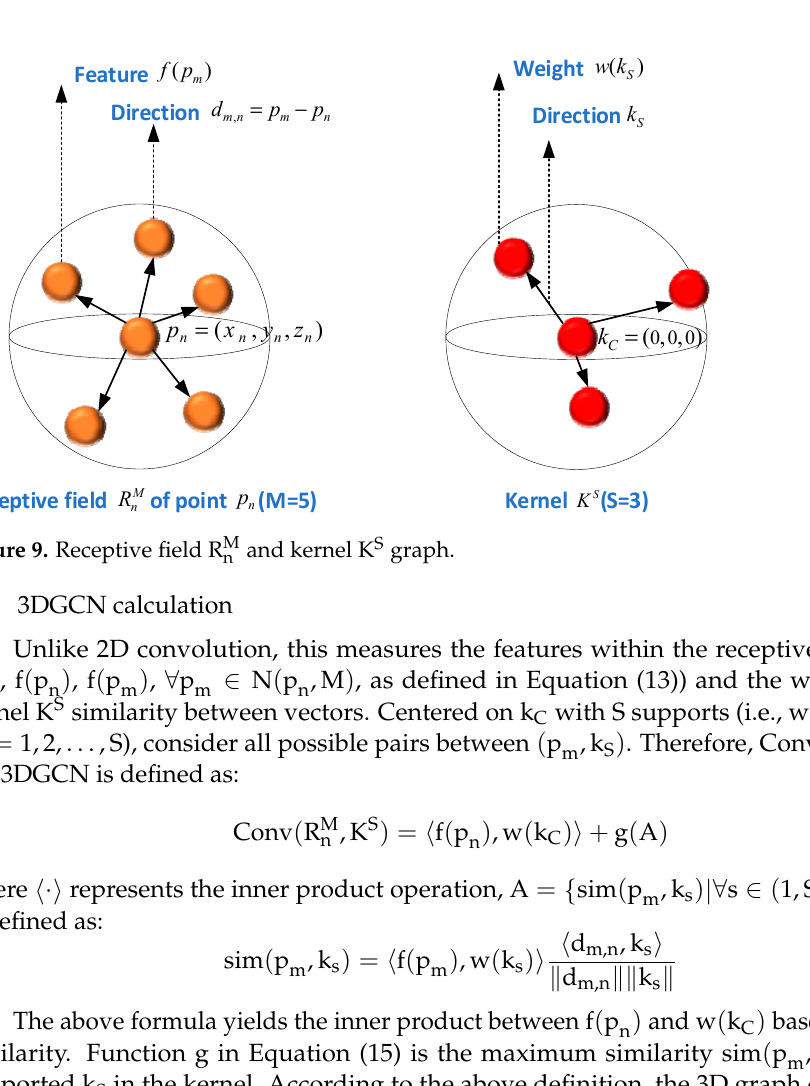
M R and kernel K S graph. n